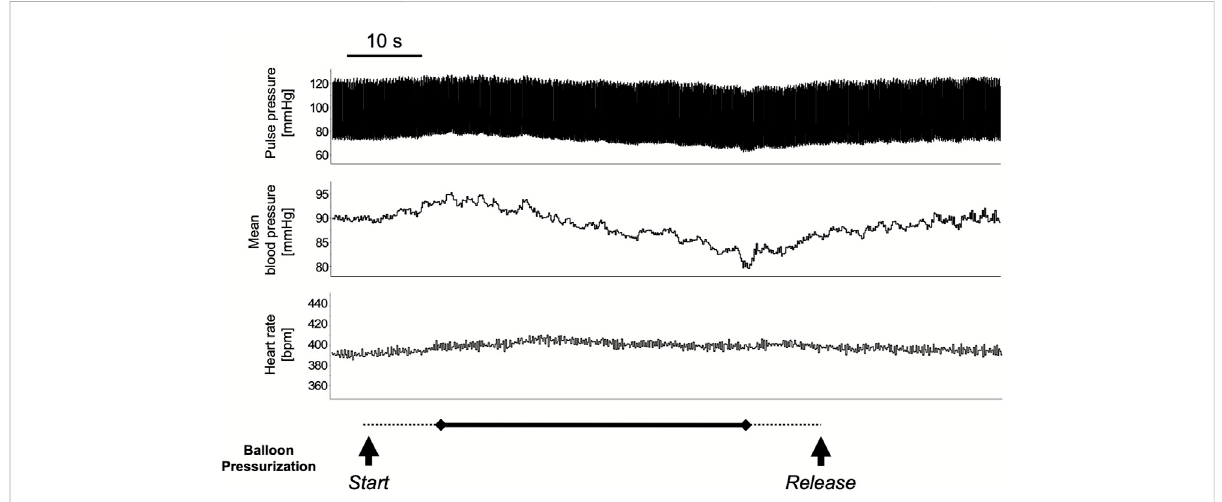
FIGURE 1 A typical response in circulatory dynamics with colorectal distension while balloon pressure is set at 80 mmHg. The distension procedure was performed by gradually increasing the targetpressure for 10 s (dashed line), maintaining the pressure for 40 s(solid line), and then releasing it in 10 s (dashed line): for a total of 60 s. Mean arterial pressure falls immediately after the start of distension and gradually recovered after the release.